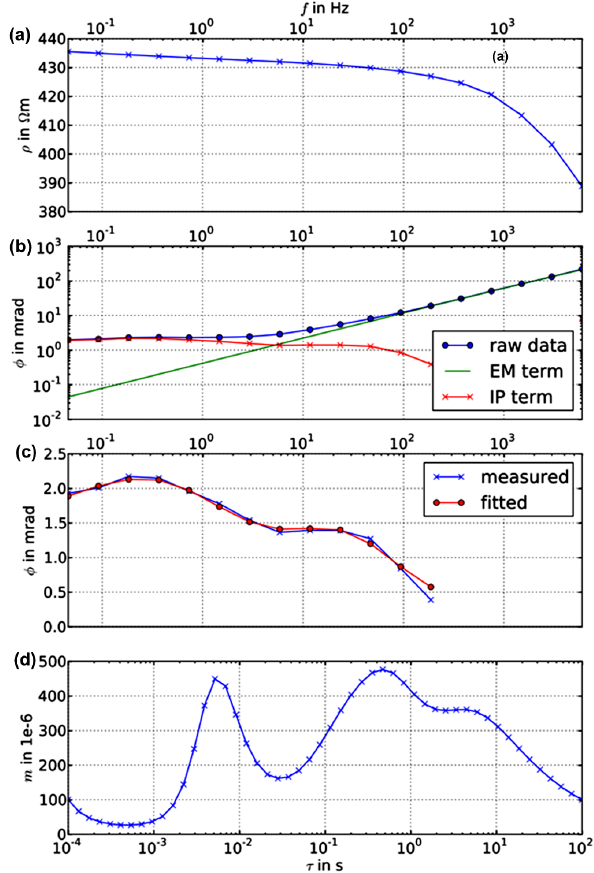
Fig. 12. SIP lab data of one core sample at 6.68 m depth. (a) Resistivity amplitude (|ρ|). (b) Measured phase (φ) (blue line) values, electromagnetic (EM) term (green line) and phase values (red line) after removing EM effect. (c) The fitting between the phase values after removing EM effect (blue line) and the fitted curve (red line). (d) The variation of spectral chargeability with relaxation time by using DD model.